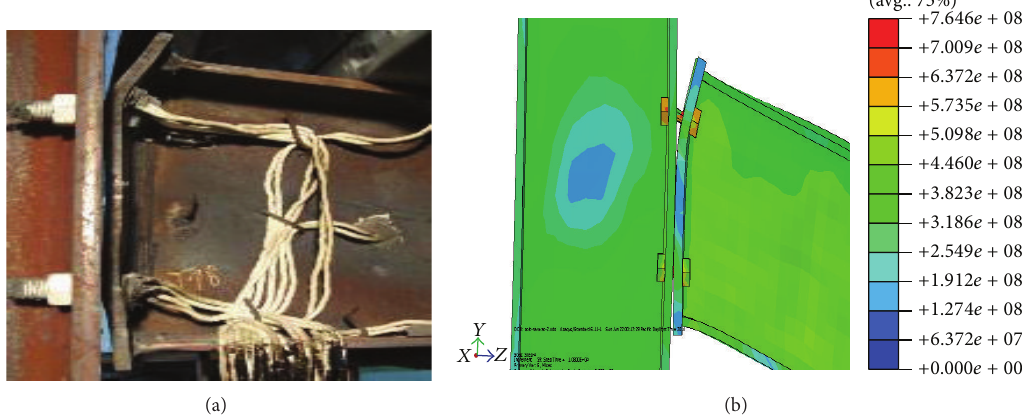
Figure 8: Breakdown of (a) laboratory sample and (b) numerical model.